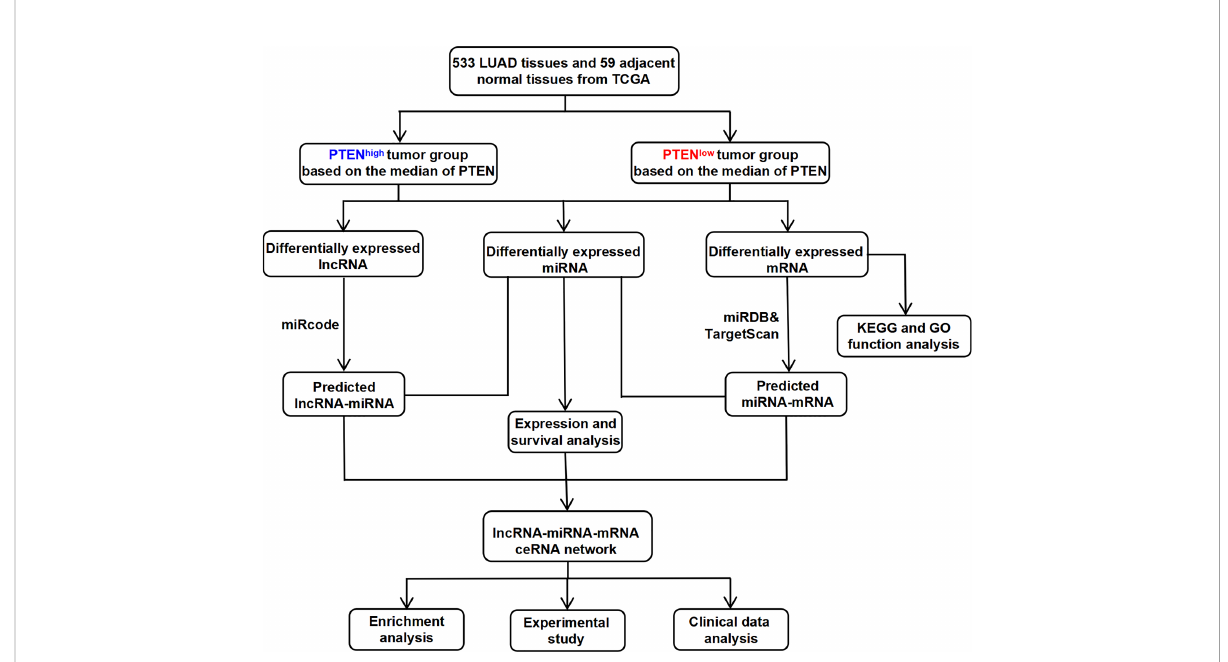
FIGURE 1 The fl ow chart for the construction process of the novel PTEN-related ceRNA regulatory network in